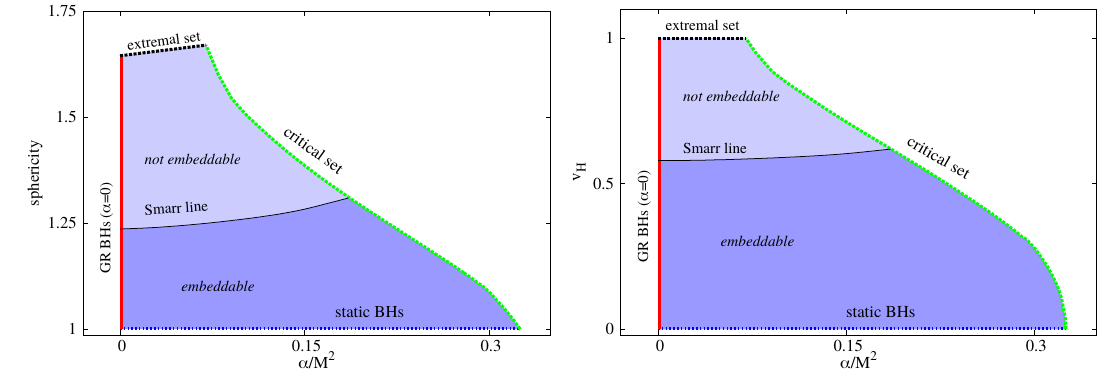
Figure 5 . The sphericity s (left panel), and the horizon linear velocity v H (right panel) vs. (cid:11)=M 2 for the full set of EsGB